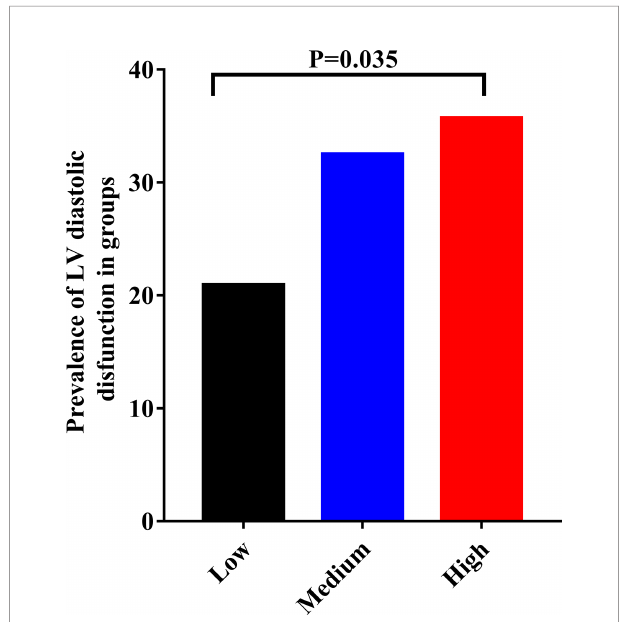
FIGURE 2 | The relationship between different NLR levels and the prevalence of LV diastolic dysfunction in patients with the overt hyperthroidism. Low = NLR<0.879 (n = 115); Medium = 0.879< NLR<1.287(n =120); High = NLR >1.287(n = 115).